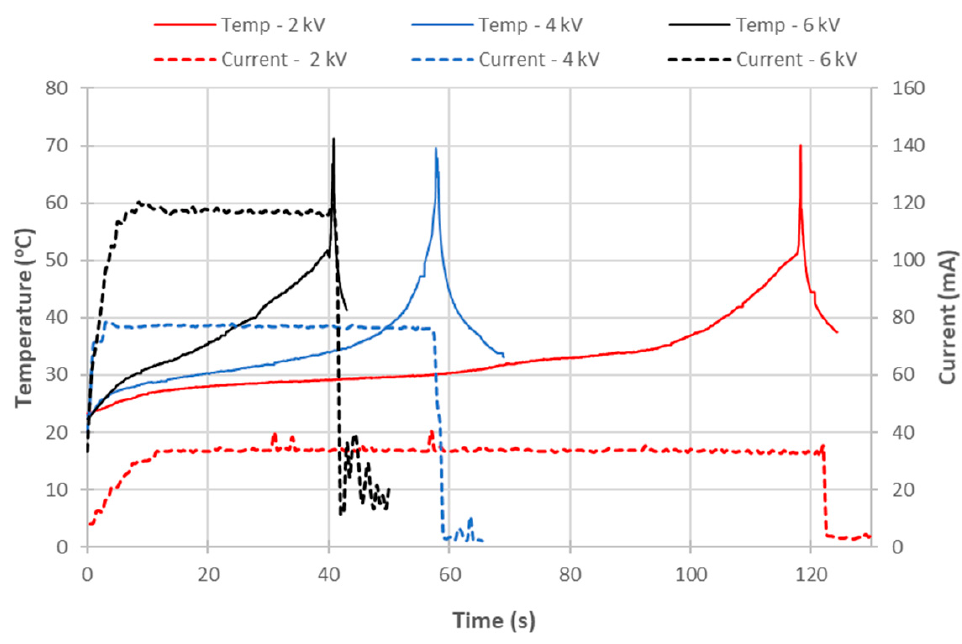
Figure 15. Examples of evolution of the maximum current value and of the temperature measured at the center of the dry band as function of applied voltage, for average ESDD of 1.34 mg/cm 2 .